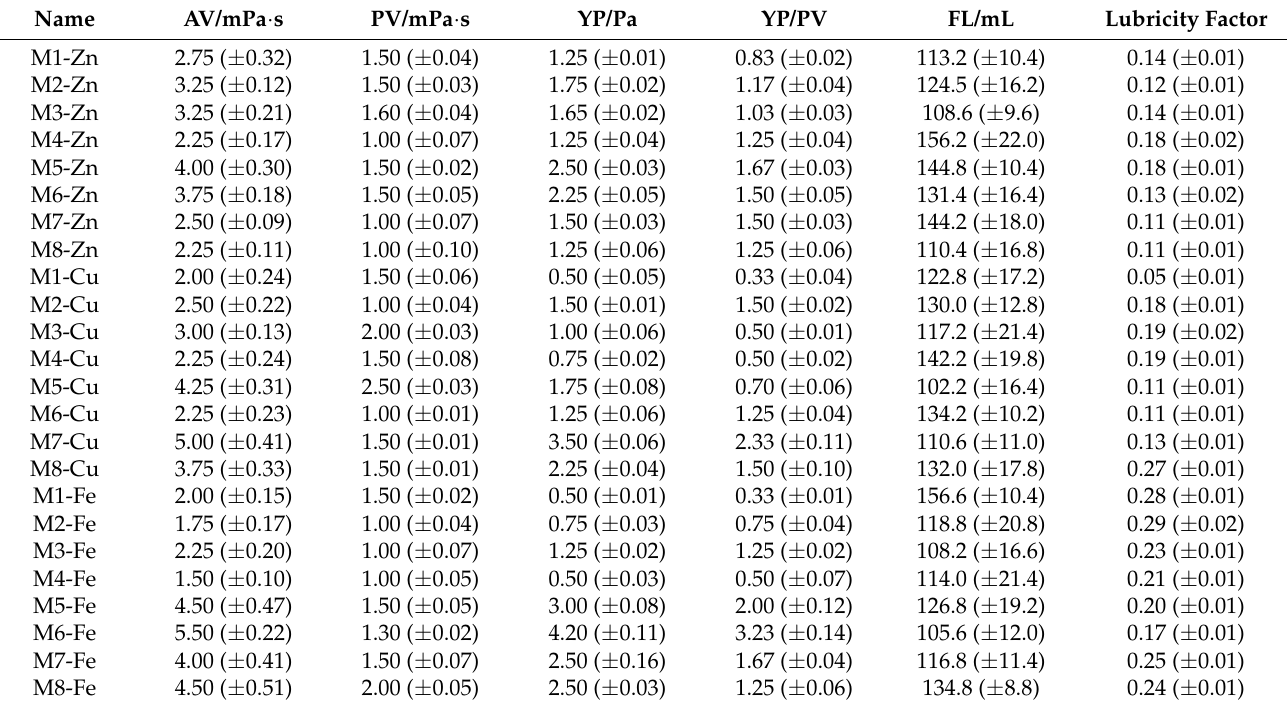
Figure 13. TEM image of M6-Fe.